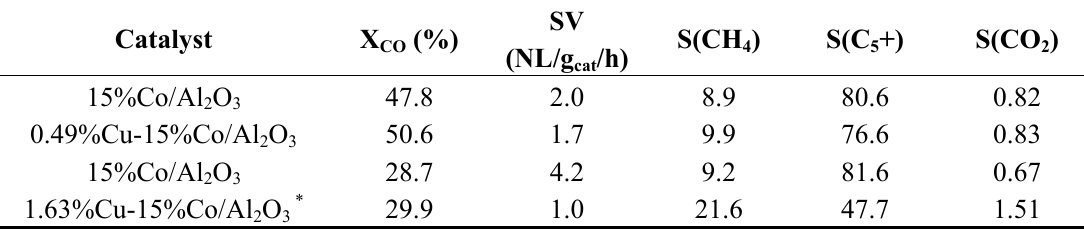
Table 2. Two comparisons of product selectivity at similar X promoted 15%Co/Al O catalysts relative to the unpromoted catalyst. Conditions: 220 2 3